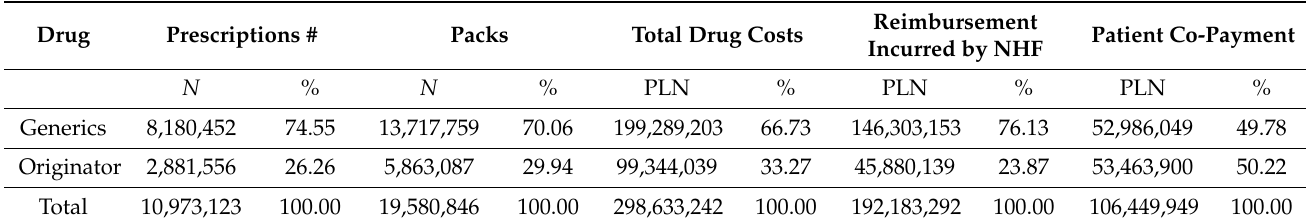
Table 1. Metformin market in Poland in 2019; data refer to the dispensation period between 1 January–31 December 2019; # numbers and percentages do not sum up to the total, as some prescriptions being issued for more than one pack of drug were dispensed in a form of both a generic and the originator drug. NHF: National Health Fund. PLN: Polish